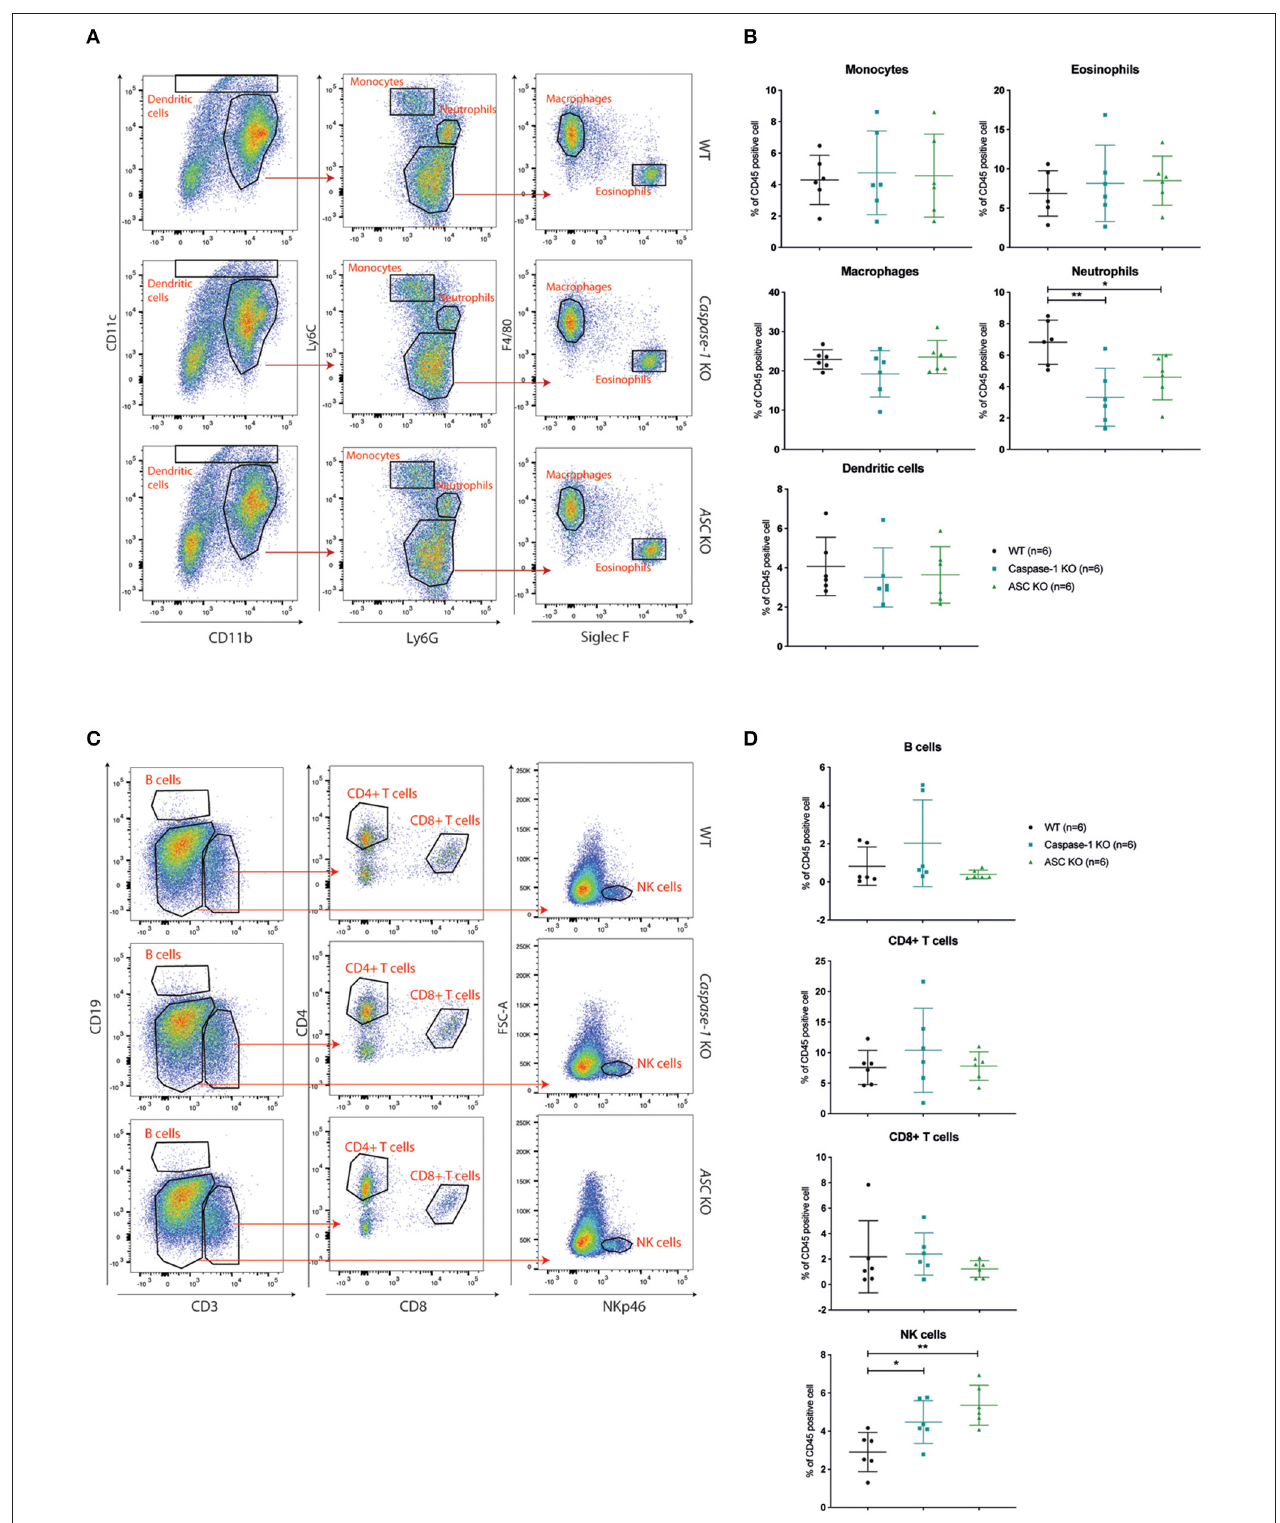
FIGURE 4 | Caspase-1 or ASC deficiency improves NK cell recruitment 14 days post-injection. (A) Flow cytometry analysis of myeloid cell populations in 4T1 tumors at day 14 post-injection from WT ( n = 6), Caspase-1 KO ( n = 6), and Asc KO ( n = 6) mice. The displayed dotplots were obtained by gating live and CD45 + cells. (B) Quantification and analysis of myeloid cell populations in the different mouse genotypes. (C) Flow cytometry analysis of lymphoid cell populations in 4T1 tumors from the same mice as in A. The displayed dotplots were gated from live and CD45 + cells. (D) Quantification and analysis of lymphoid cell populations in the different mouse genotypes. Data represent mean ± SD * P < 0.05; ** P < 0.01 (One-way ANOVA test followed by Bonferroni’s Multiple Comparison Test).